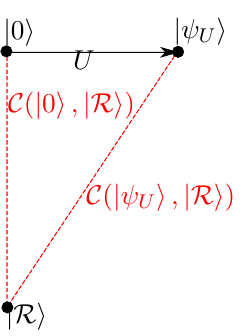
Figure 2 . The space of states with the reference state jRi , the groundstate j 0 i and the state j U i (cid:17) U j 0 i for the generator U of a small conformal transformation. The red dashed lines signify the complexities of the states j U i and j 0 i with respect to the reference state jRi